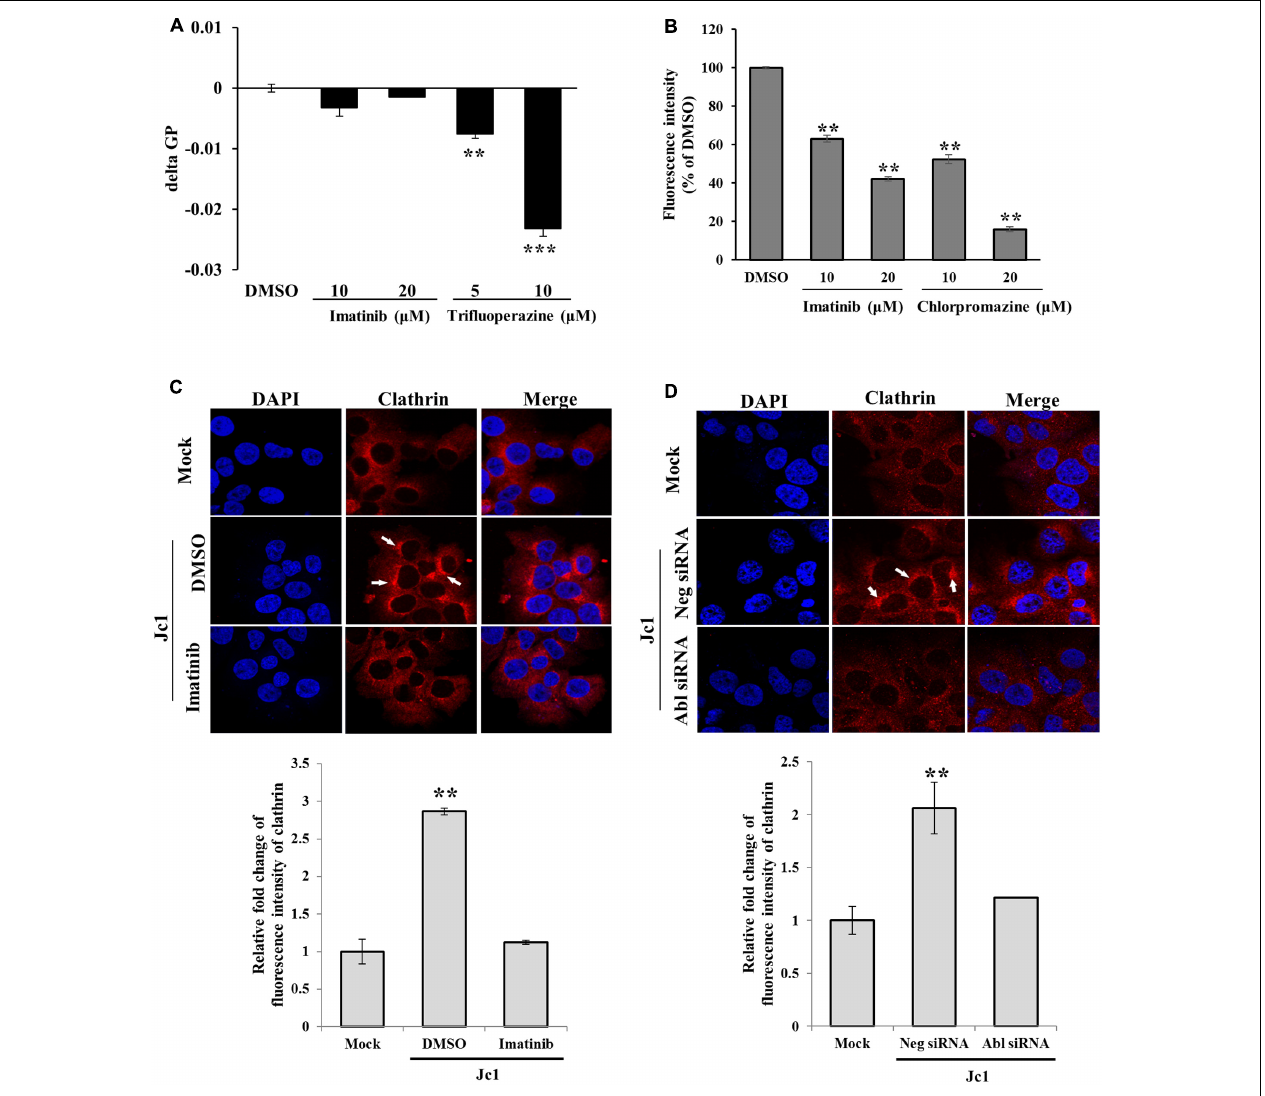
FIGURE 5 | Abl is required for the clathrin-mediated endocytosis. (A) Huh7.5 cells were treated with either DMSO or the indicated concentration of imatinib or trifluoperazine for 2 h at 37 ◦ C. Cells were further treated with membrane fluidity detection dye for 20 min at 25 ◦ C and then wavelength was detected. Generalized polarization (GP) = ( I 405- I 460)/( I 405+ I 460), where I 405 and I 460 are the fluorescence intensity measured under wavelength 405 and 460, respectively. The asterisks indicate significant differences ( ∗∗ P < 0.01; ∗∗∗ P < 0.001) from the value for the DMSO control. (B) Huh7.5 cells were incubated with serum-free DMEM in the presence of either DMSO or the indicated concentrations of imatinib or chlorpromazine. The cells were incubated with 10 µ g/ml Texas Red-conjugated transferrin in serum-free DMEM supplied with 1% BSA for 1 h at 4 ◦ C. The cells were fixed in 4% paraformaldehyde. Fluorescence intensity was determined by measuring the internalized transferrin using Image J. (C) (Upper panel) Huh7.5 cells were treated with either DMSO or imatinib for 4 h at 37 ◦ C and then infected with Jc1 using an MOI of 5. The cells were then fixed in 4% paraformaldehyde and stained with anti-clathrin heavy chain and TRITC antibodies. Cells were counterstained with 4 (cid:48) ,6-diamidino-2-phenylindole (DAPI) to label nuclei (blue). (Lower panel) Fluorescence intensity of clathrin was quantified by using ImageJ software. (D) (Upper panel) Huh7.5 cells were transfected with either negative siRNA or Abl-specific siRNAs for 48 h and then infected with Jc1 using MOI of 5. At 30 min post-infection, cells were fixed in 4% paraformaldehyde and stained with anti-clathrin heavy chain and TRITC antibodies. Cells were counterstained with DAPI to label nuclei. (Lower panel) Fluorescence intensity of clathrin was quantified by using ImageJ